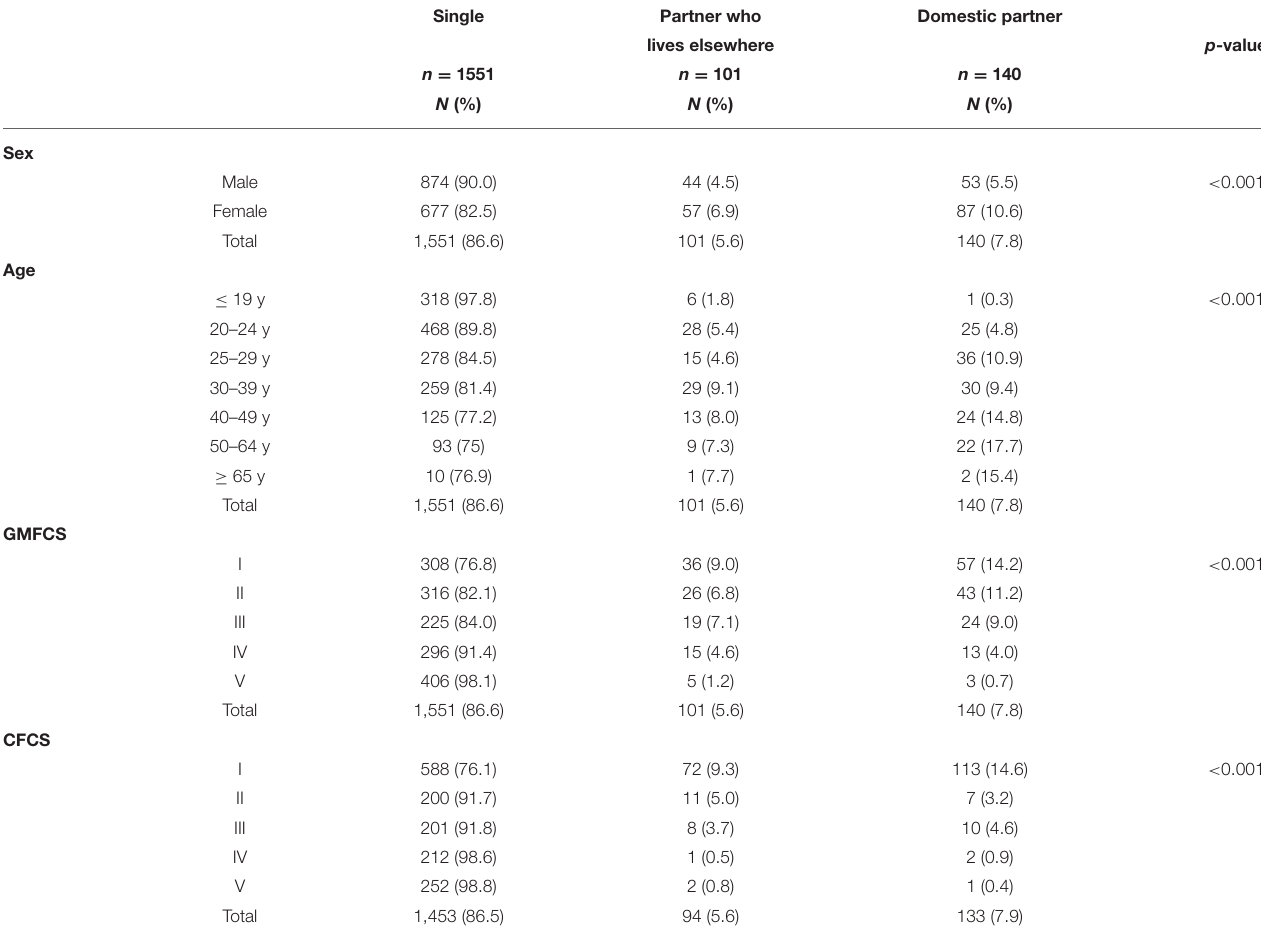
TABLE 2 | Adults who are single or have a partner, relative to their sex, age, GMFCS and CFCS levels. Single Partner